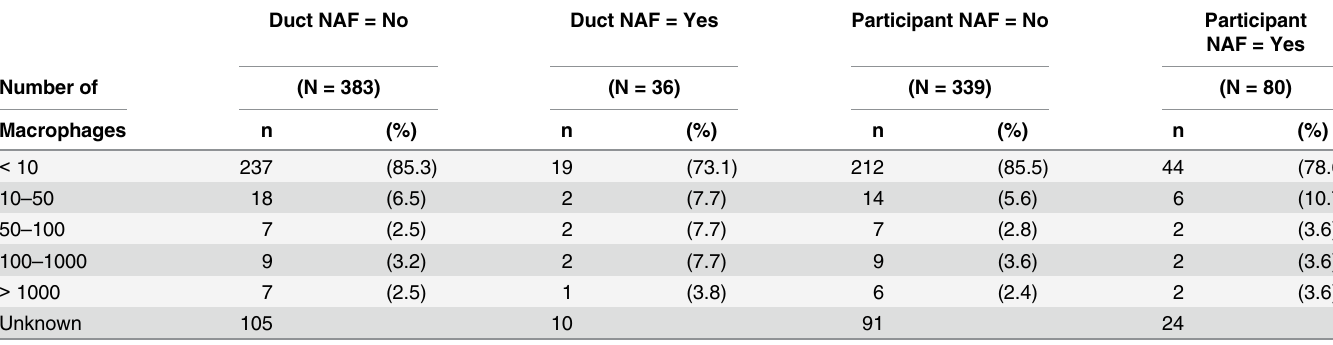
Table 6. Number of Macrophages by Duct- and Participant-Level NAF